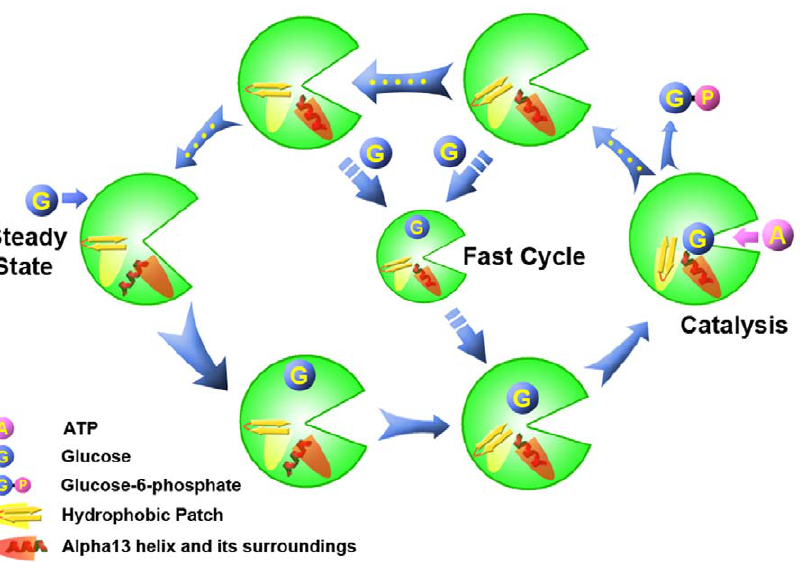
Figure 9. An atomic mechanism for the whole catalytic circulation of GK. The width of the arrow indicates the time scale in the conformational pathway, and yellow dots in the arrow represent the intermediate state of the energy well in the activation-inactivation-activation process.